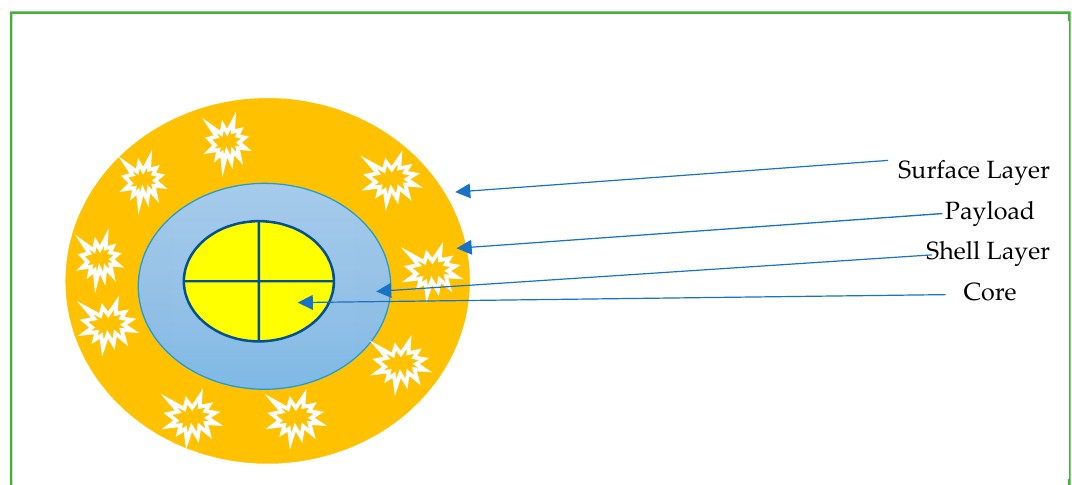
Figure 1. Common schema for nanoparticles for intratumoral delivery.